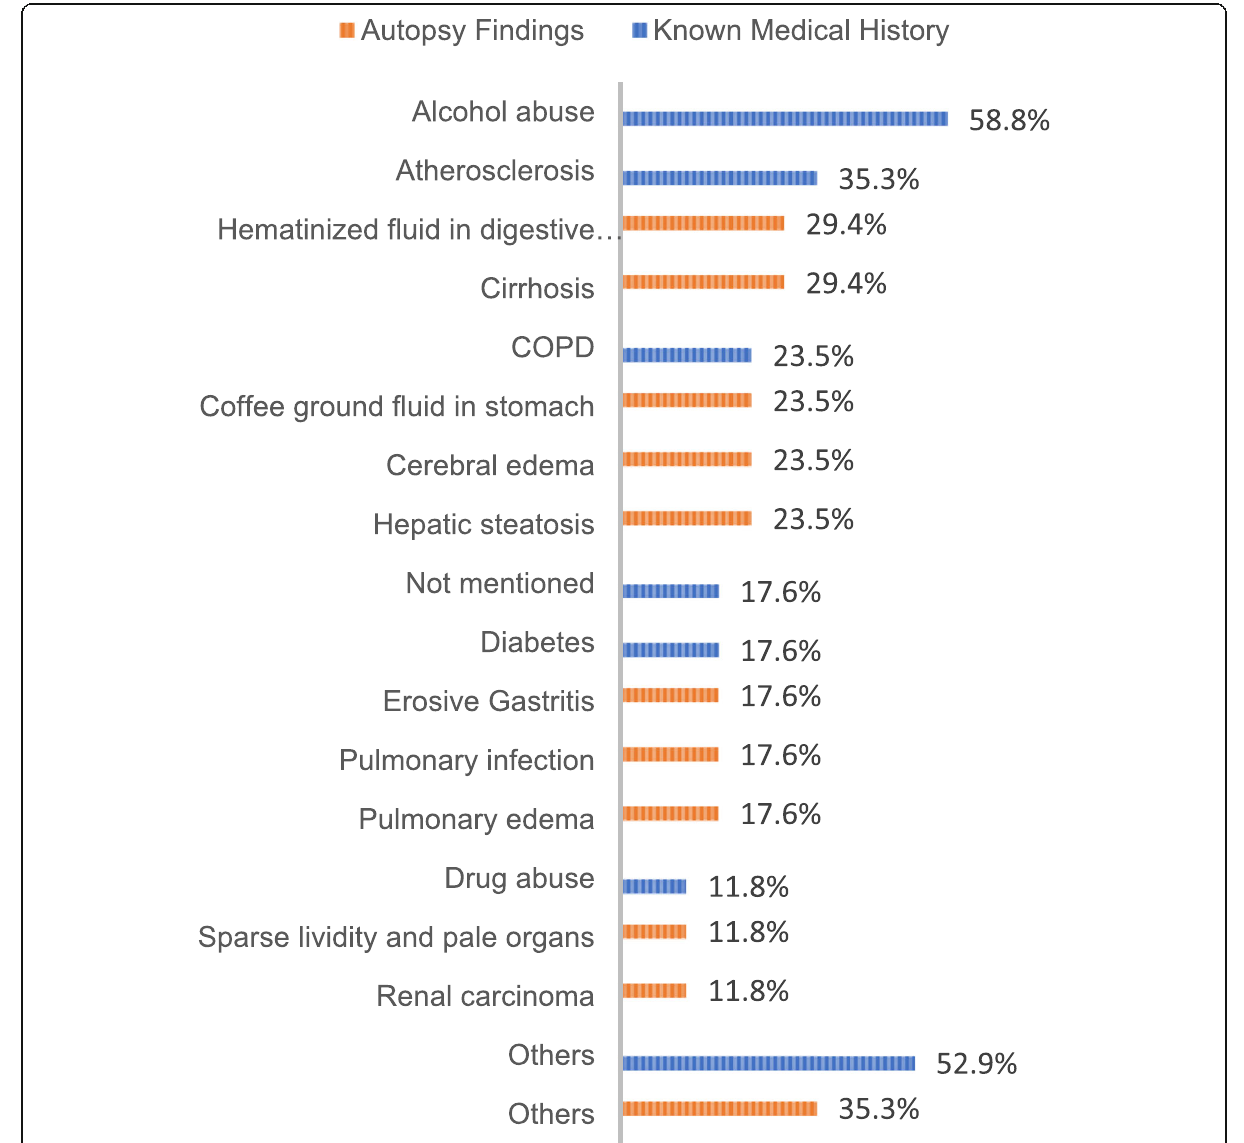
Fig. 4 Figure resuming relevant autopsy findings and known medical history by their respective frequencies. COPD chronic obstructive pulmonary disease. Others in autopsy findings: myocardial infarct (1), chronic pancreatitis (1), acute pancreatitis (1), deep decubitus ulcers with osteomyelitis (1), peritonitis (1), perforated duodenal ulcer (1). Others in known medical history: intellectual disability (1), psychiatric disorder (1), bedridden (1), hemorrhagic stroke (1), alcohol withdrawal for 6 months (1), seizures (1), high blood pressure (1), smoking (1), none